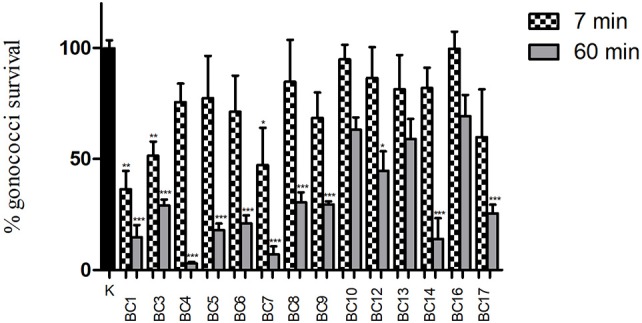
“Inhibition” experiments with lactobacilli cells. Experiments were performed with 1 × 108 CFU of lactobacilli incubated with 1 × 108 gonococcal cells at two different time points: 7 min (dotted bars) and 60 min (gray bars). GC viability was evaluated as number of gonococci/mL and expressed as % of gonococci survival. The results were expressed in percentage compared to control (K) (1 × 108 gonococcal cells incubated in PBS, without lactobacilli), taken as 100% (black bar). Bars represent mean values, whereas error bars represent SEM. Statistical significance was determined at *P < 0.05, **P < 0.01, and ***P < 0.0001.